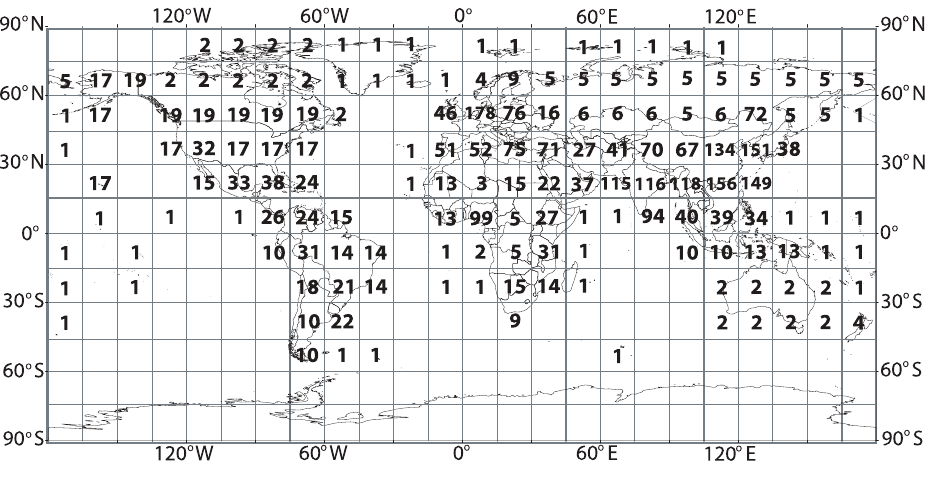
Figure 3. The number of Internet users, divided by 10 6